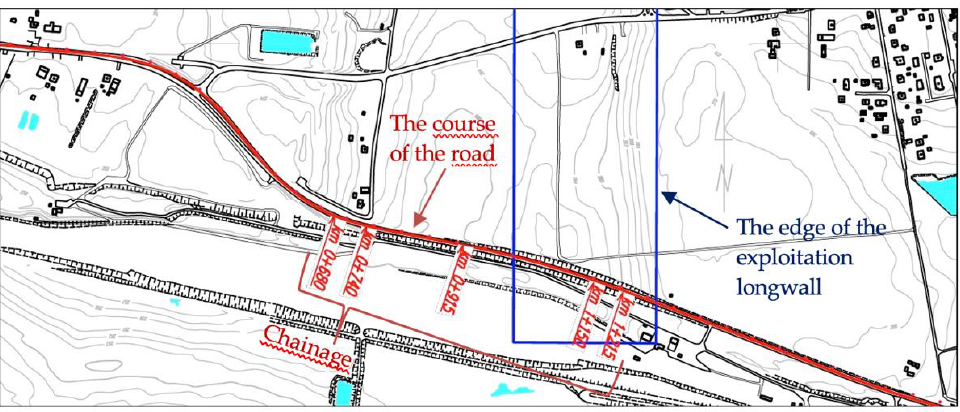
Figure 8. Location of a longwall exploited in 2021 under a right-of-way.